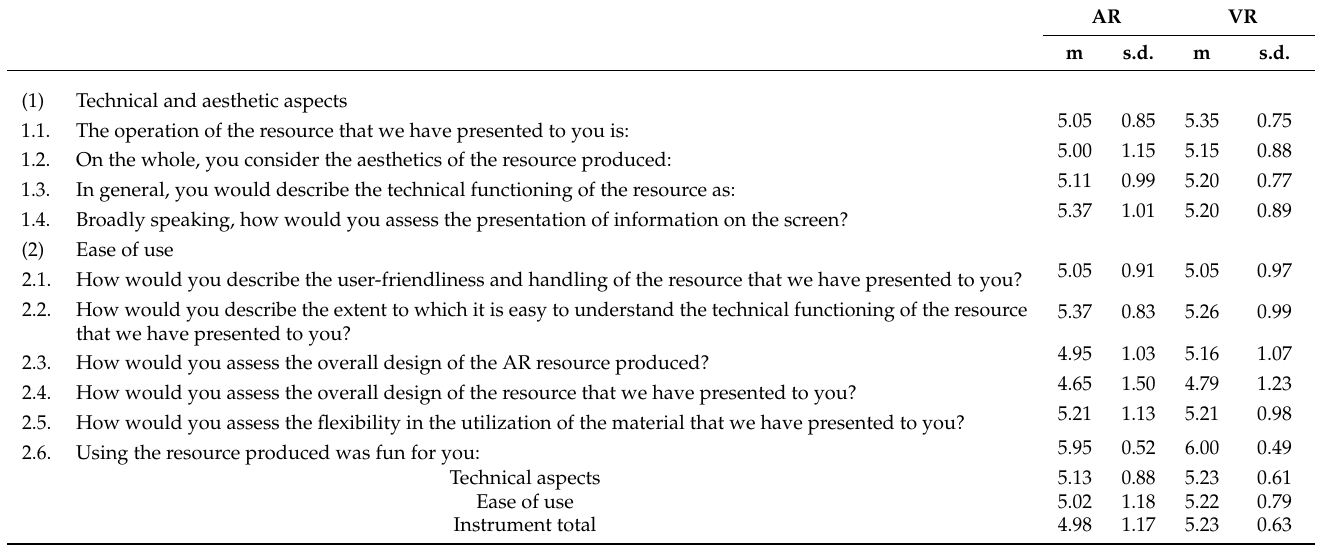
Table 7. Mean scores and standard deviations for each of the dimensions. Source: developed by the